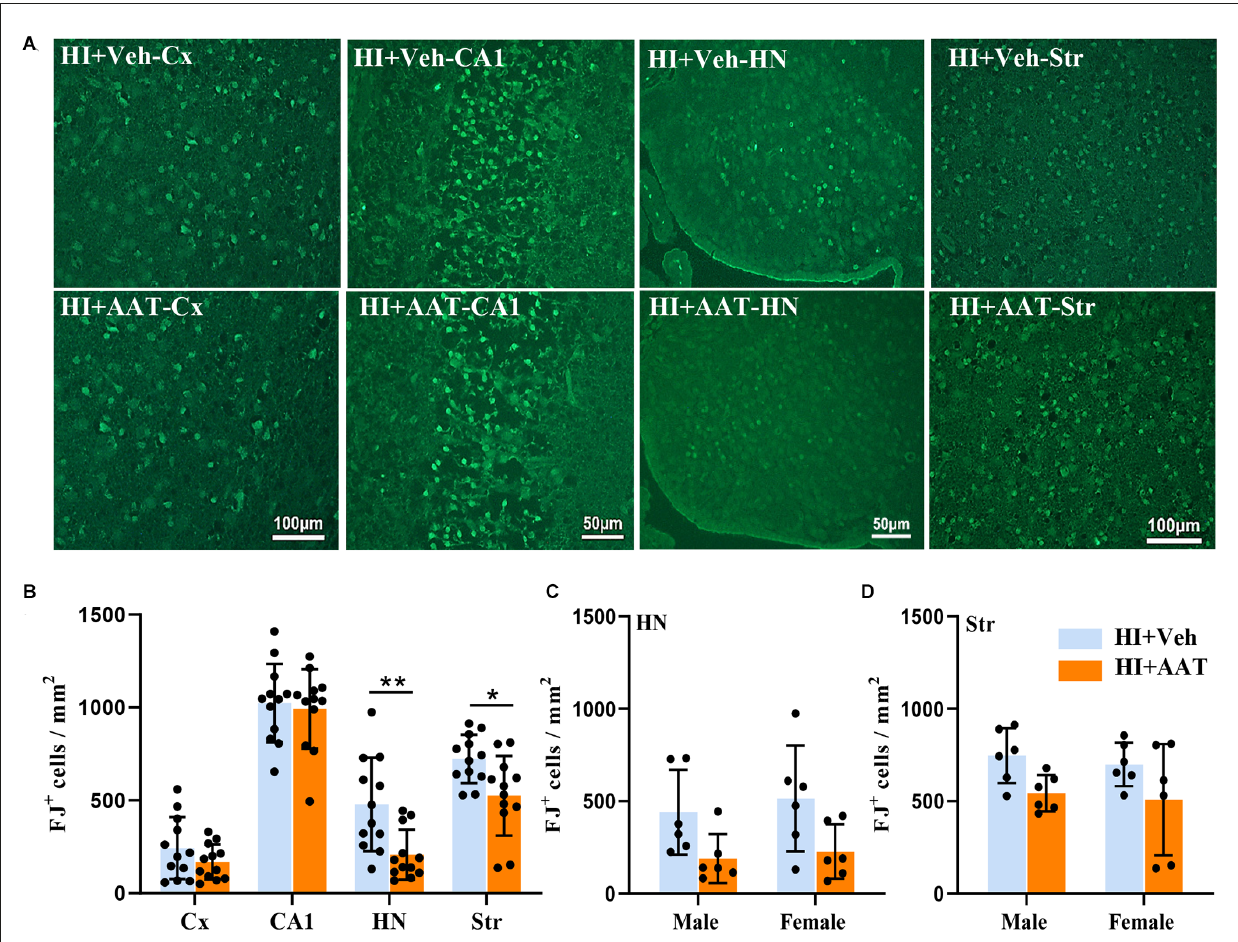
FIGURE5 Neuronal cell death in neonatal HI mice after AAT treatment. (A) Representative Fluoro-Jade B staining in the cortex (Cx), hippocampus (CA1), habenula nucleus (HN), and striatum (Str) at 24 h after HI in vehicle-treated and AAT-treated groups. (B) Quantification of Fluoro-Jade B-labeled cells at 24 h after HI in the Cx, CA1, HN, and Str [ n = 12/group, cortex ( p = 0.192), CA1 ( p = 0.719), HN ( p = 0.005), Str ( p = 0.012)]. (C) Quantification of Fluoro-Jade B-labeled cells in the habenula nucleus area at 24 h after HI in male and female mice ( n = 6/group, p = 0.05 for males and p = 0.054 for females). (D) Quantification of Fluoro-Jade B-labeled cells in the striatum area at 24 h after HI in male and female mice ( n = 6/group, p = 0.07 for males and p = 0.087 for females). * p < 0.05, ** p <